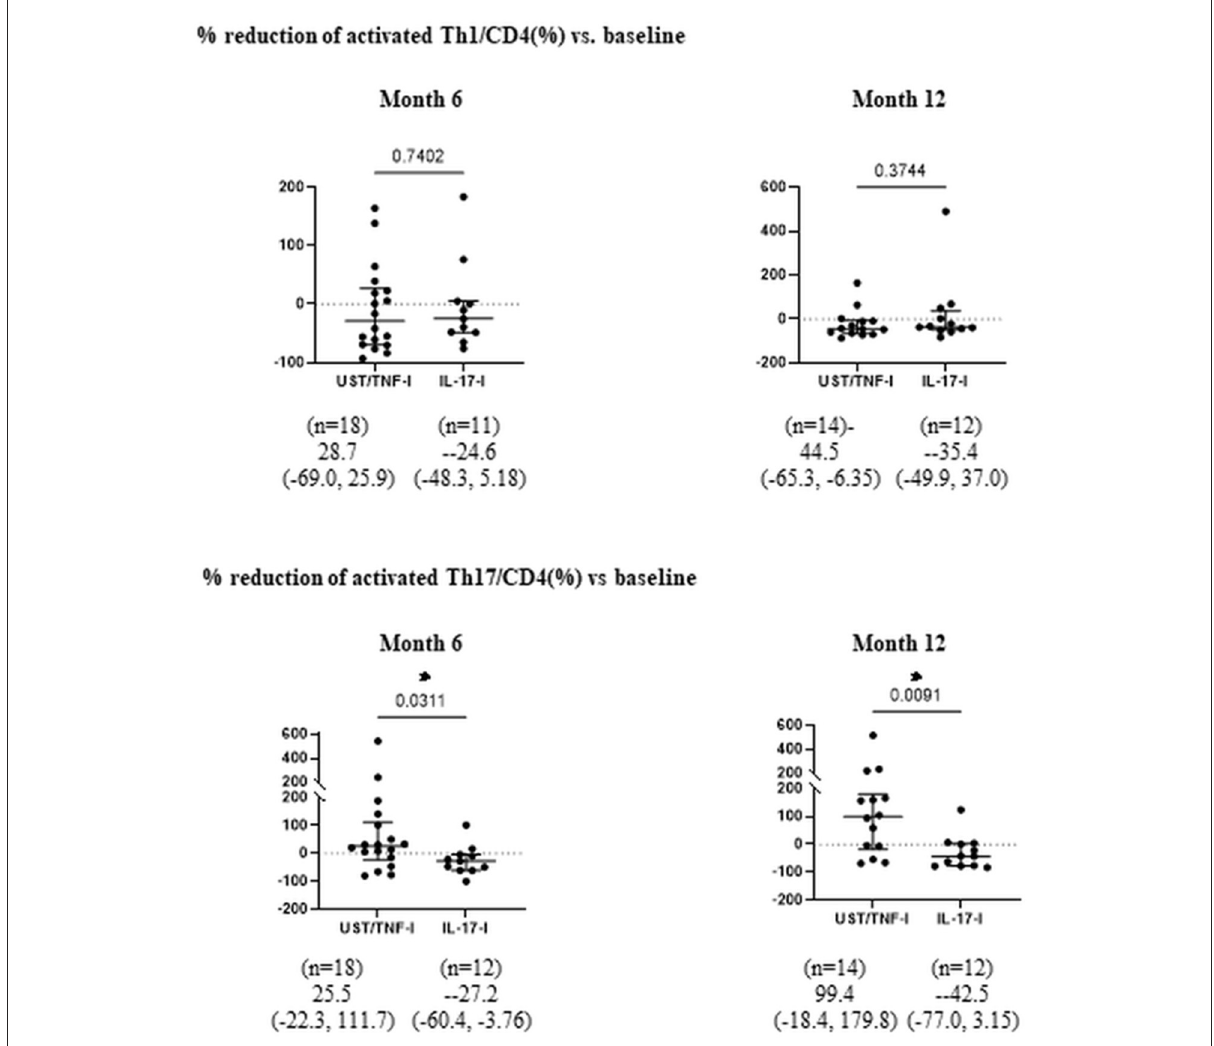
FIGURE3 Comparison of percent reduction of aTh1/Th17 cells after bDMARDs treatment. Data are presented as the median (interquartile range [IQR]). * P < 0.05, Mann-Whitney U test. UST, ustekinumab; IL-17-i, IL-17 inhibitors; TNF-i, TNF inhibitors, index, aTh1: activated Th1 cells; aTh17, activated Th17